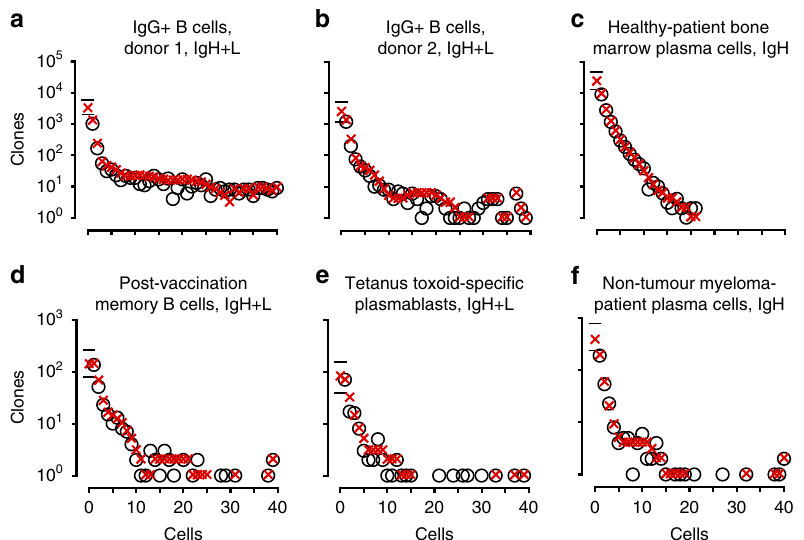
Figure 5 | Predictions versus observations, experimental data. Shown are Recon’s estimates of overall diversity for six experimental data sets. These included ( a , b ) immunoglobulin heavy (IgH)- and light-chain (IgL) paired-chain sequencing experiments from IgG þ B cells from the blood of two different subjects, ( c ) pooled-DNA IgH sequencing experiments on the bone-marrow plasma cells from a healthy adult, ( d ) IgH þ L of post-vaccination memory B cells, ( e ) IgH þ L tetanus toxoid-specific plasmablasts and ( f ) pooled-DNA IgH sequencing experiments on the bone-marrow plasma cells from a multiple myeloma patient (only the non-myeloma cells). Details, including references, are presented in Table